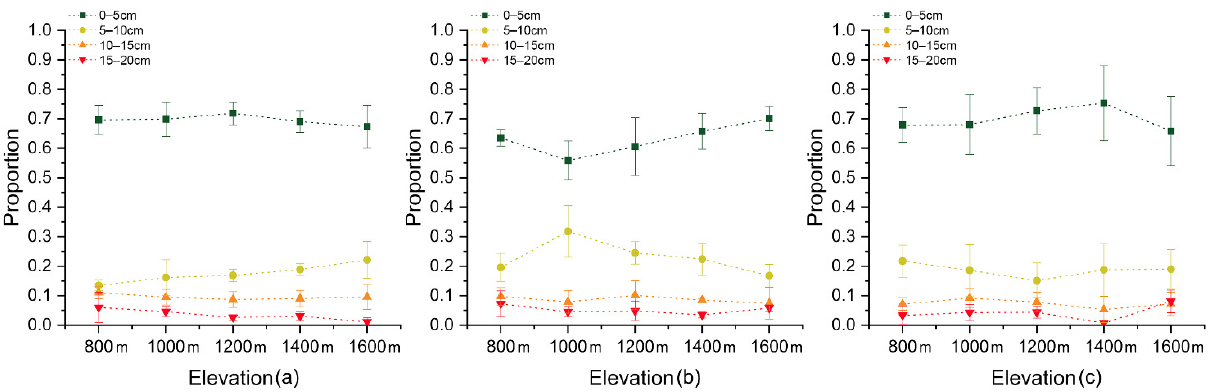
Figure 6. The proportion of seed bank density at different depths in the soil profile (0–20 cm) with elevation in April ( a ), July ( b ) and October ( c ).